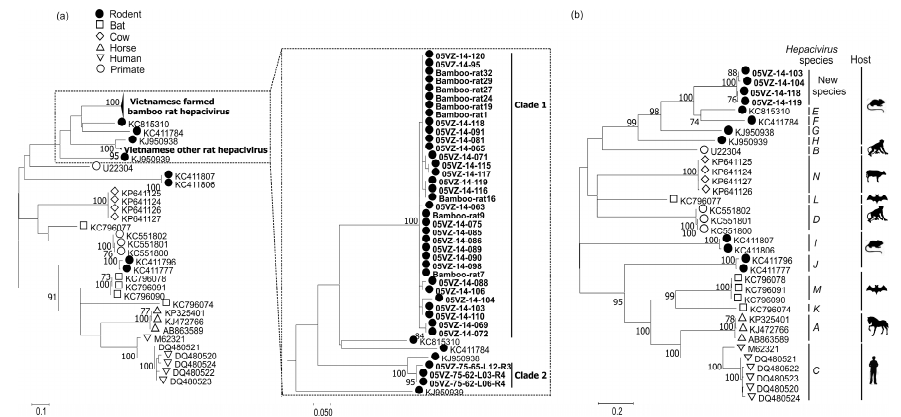
Figure 2. Maximum likelihood trees of ( a ) the screening fragment and ( b ) the amino acid region 1123–1566 of hepaciviruses using best-fitting models of rtREV+G+I and LG+G+I, respectively. The magnified box shows the two Vietnamese rodent hepacivirus clades. Labels for sequences obtained in this study are highlighted in bold. Bootstrap support values of ≥ 70% are shown. The trees were drawn to scale; bar, estimated number of substitutions per site. Table 2. Nucleotide and amino acid identities of Vietnamese rodent and bat virus sequences to the closest matches.